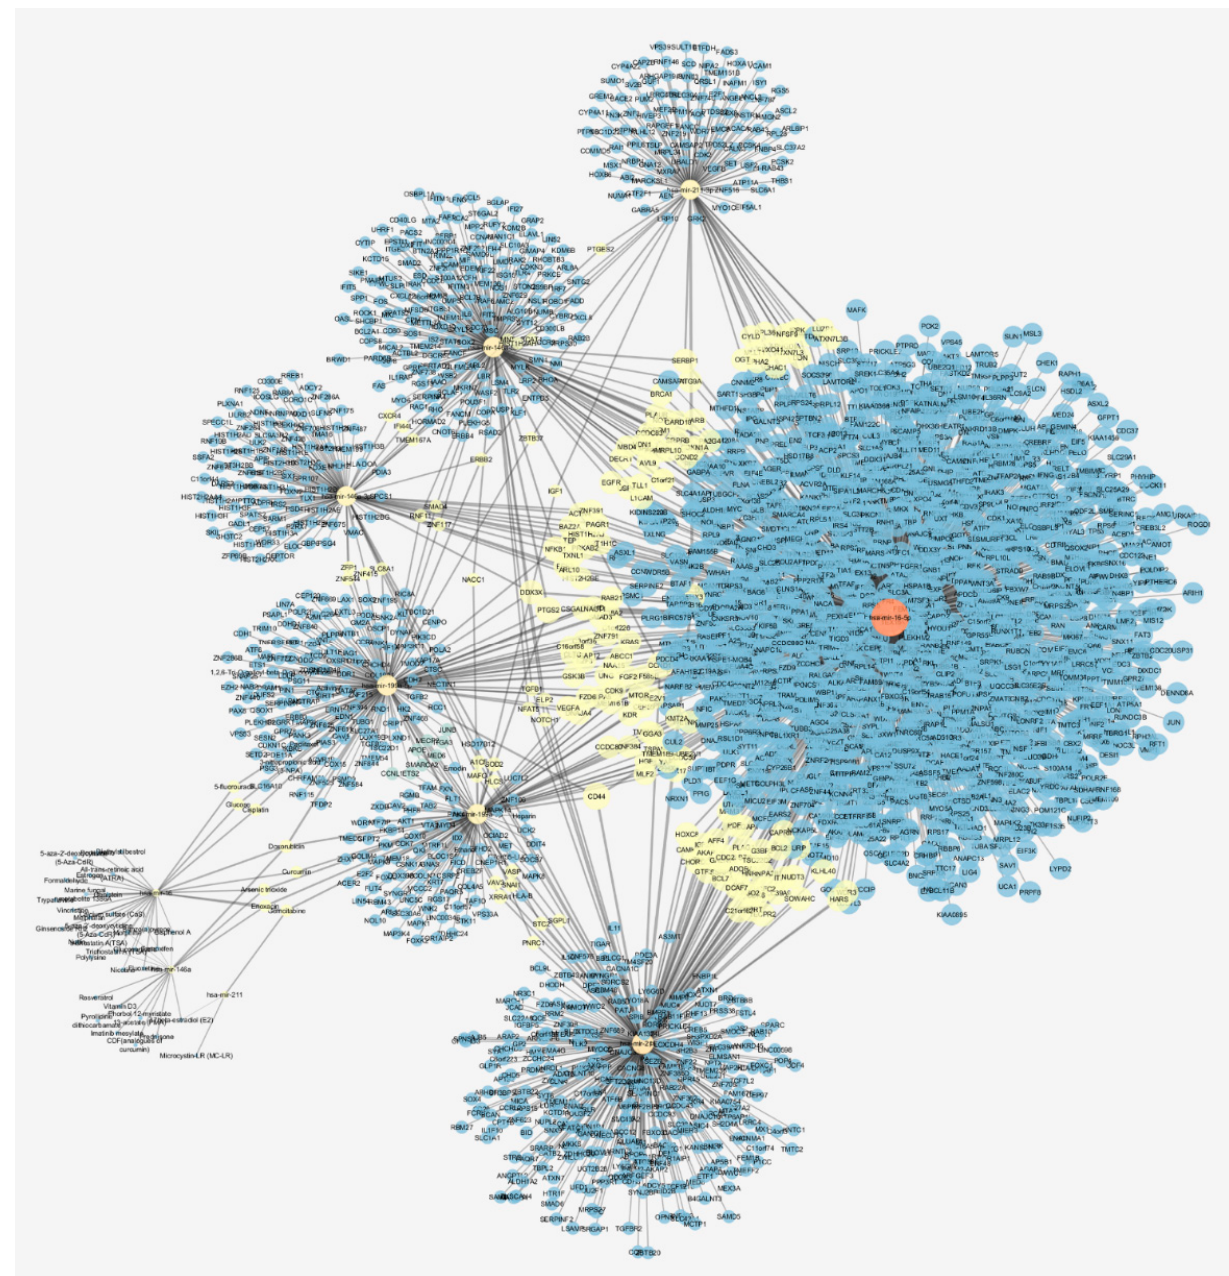
Figure 1. Gene–miRNA interactions were collected from three well-annotated databases: miRTarBase (https://mirtarbase.cuhk.edu.cn/~miRTarBase/miRTarBase_2022/php/index.php, accessed on 22 November 2021), TarBase v.8 (https://carolina.imis.athena-innovation.gr/diana_tools/web/index.php?r=tarbasev8%2Findex, accessed on 22 November 2021), and miRecords (http://c1.accurascience.com/miRecords/, accessed on 22 November 2021). The miRNA–compound interaction data were collected from SM2miR (http://www.jianglab.cn/SM2miR/, accessed on 22 November 2021) and PharmacomiR (http://www.pharmaco-mir.org/, accessed on 22 November 2021). Centrality network parameters (crucial for identification of nodes important for network stability) were calculated by using Cytoscape Network Analysis. Node dimension, which is proportional to closeness centrality values, and node color (blue < red) represents betweenness centrality values. Node thickness is proportional to edge betweenness values. Closeness centrality: distance of each node from all other nodes of the network; betweenness centrality: measure of the importance on a node basing on the shortest paths it is included into; edge betweenness: number of shortest paths between nodes that contain the